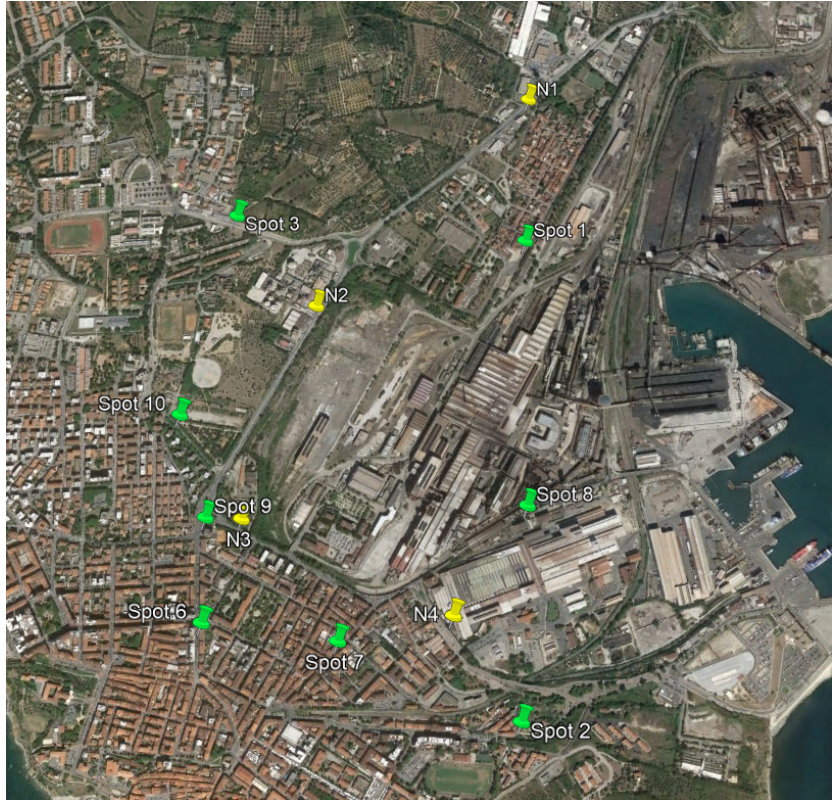
Figure 8. Aerial picture of Piombino with the positioning of long term (yellow) and short term (green) measurements. “Spot” measurements are the short-terms one, while the “N”s are the long-term.